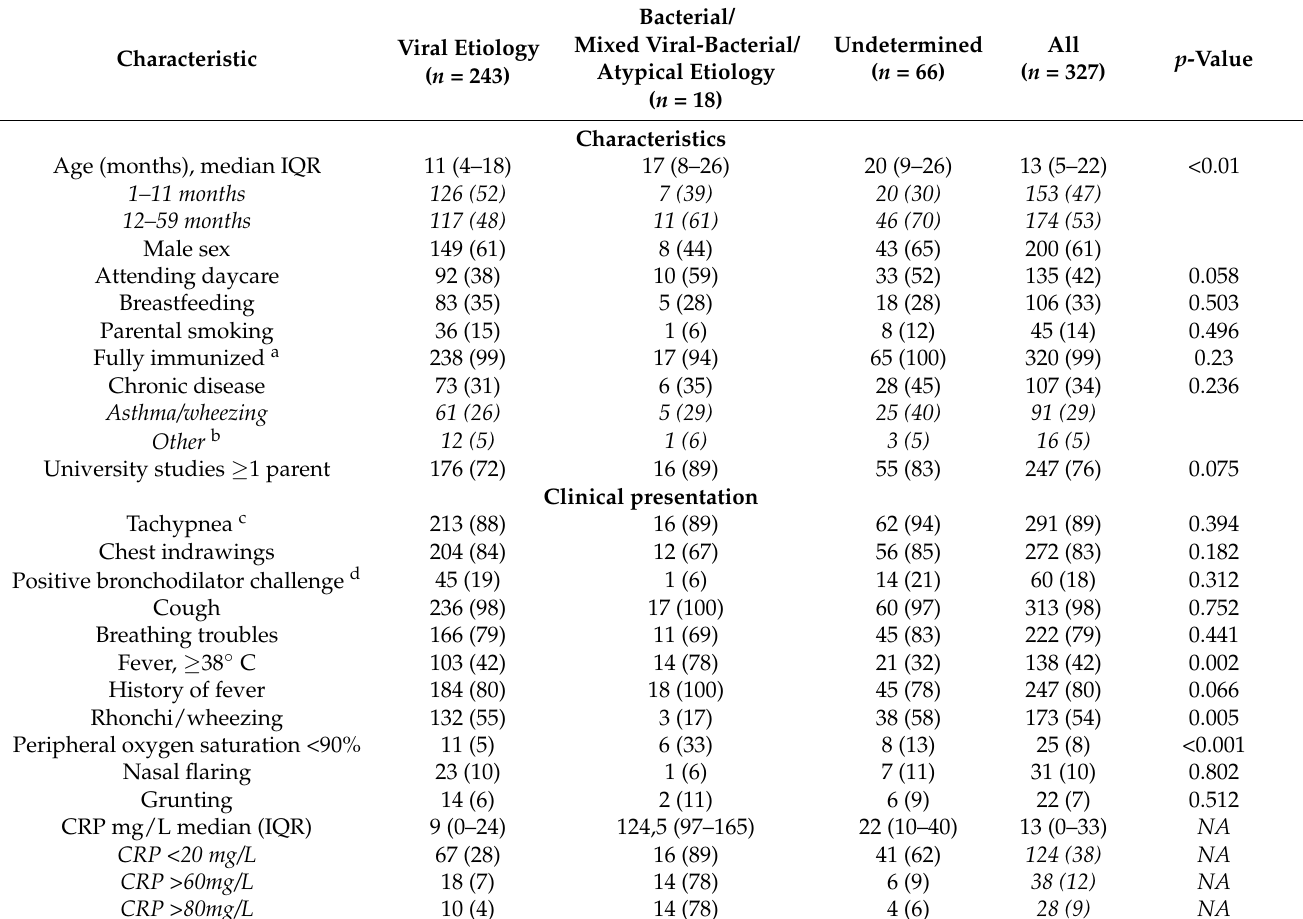
Table 1. Sociodemographic characteristics and clinical presentation of study participants according to the TREND etiology algorithm